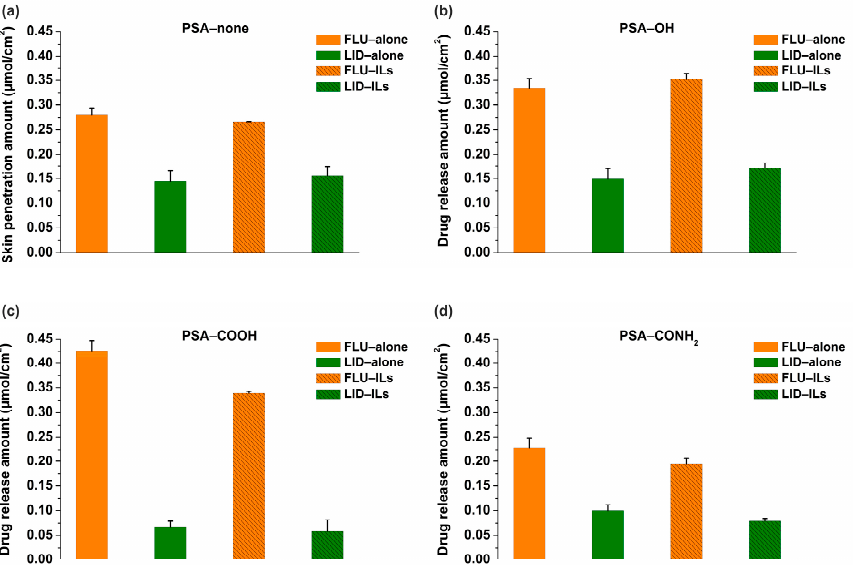
Figure 5. The in vitro release results of FLU, LID and ILs in the PSA − none ( a ), PSA − OH ( b ), PSA − COOH ( c ), and PSA − CONH 2 ( d ) ( n =